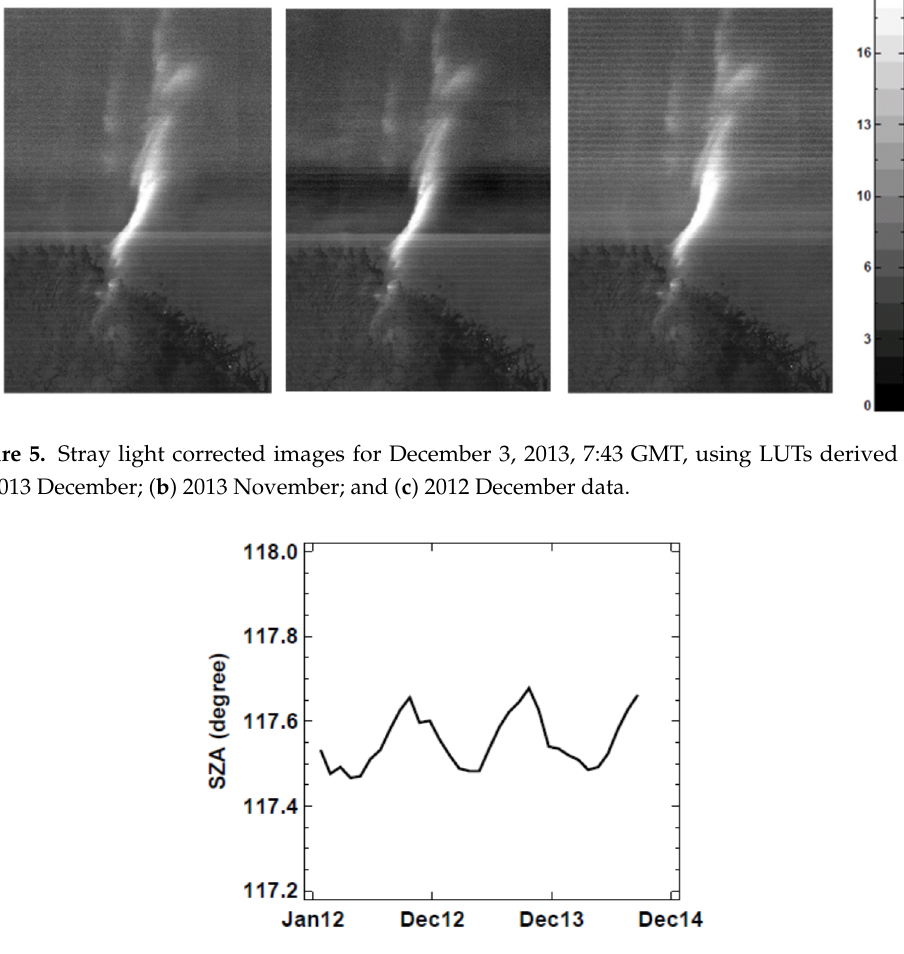
Figure 6. Median penumbra angle estimated using DNB SV data. The angle is estimated as the maximum slope in SV signal profile.